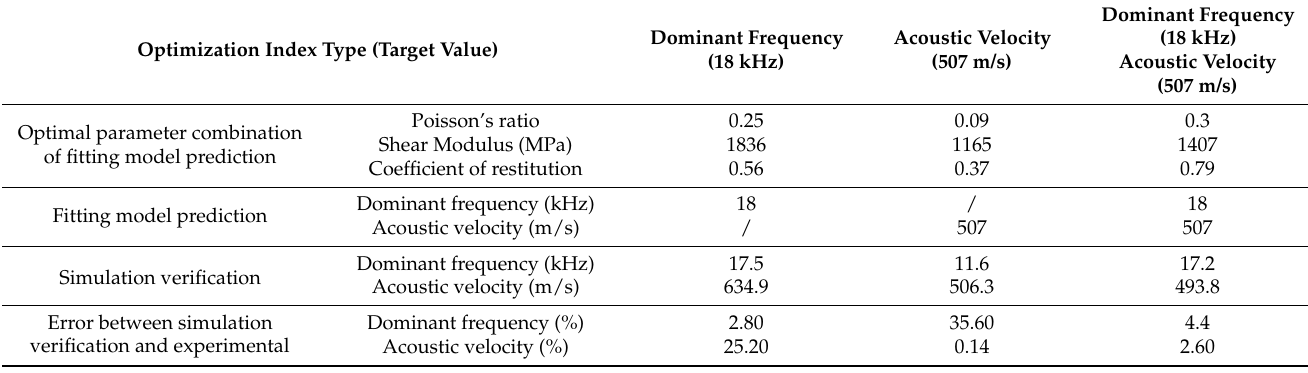
Table 10. Model prediction optimal parameter combination, prediction results, simulation verifica- tion results and errors between simulation verification and experimental results.